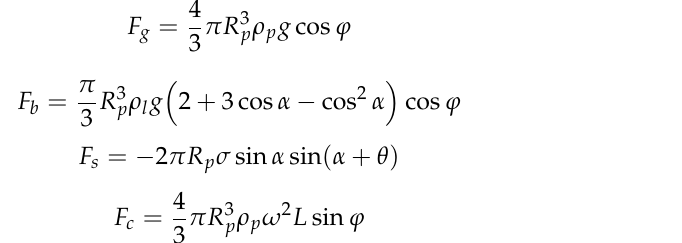
Figure 8. Forces acting on a particle trapped at the vortex surface ( a ) and contact angles of hydrophilic